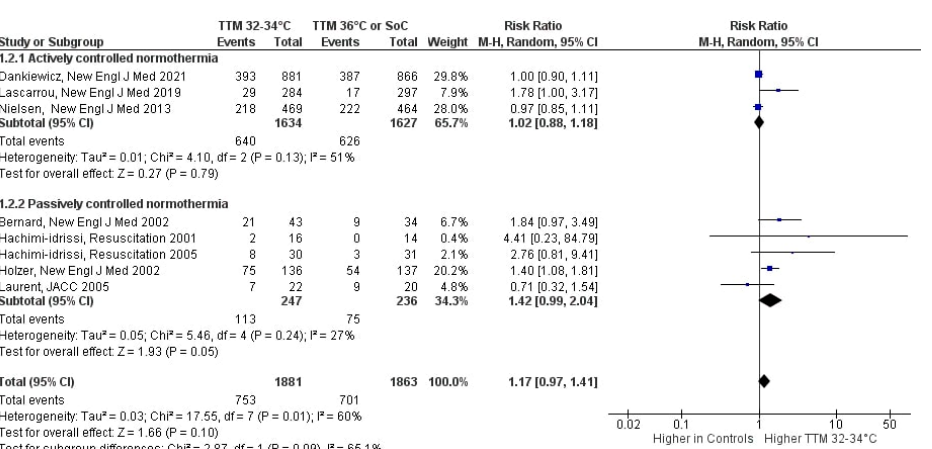
6 of 11 Figure 2. Forest plot of survival in patients resuscitated after cardiac arrest. Com-parison is made between patients according to the strategy of target temperature man-agement (TTM). CI: confi- dence interval; M-H: Mantel-Haenszel.